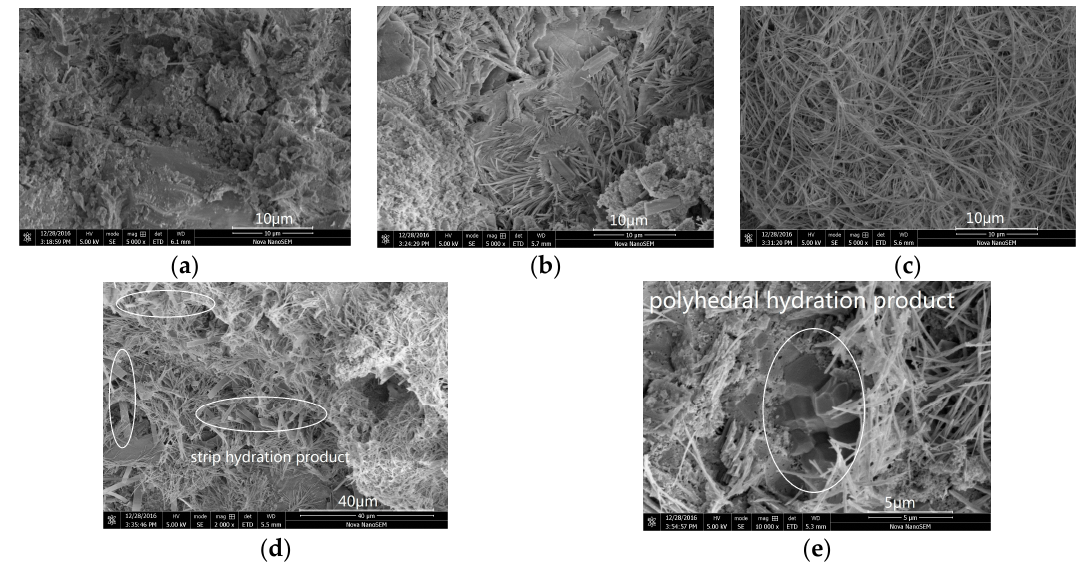
Figure 4. Morphologies of cement hydrates with different GO contents at an age of 28 days. ( a ) Control; ( b ) 0.02% GO; ( c ) 0.04% GO; ( d ) 0.06% GO, many flat and long strip hydration products appeared and embedded in the cement paste; ( e ) 0.08% GO, a polyhedral block shape products appeared and embedded in the cement paste.